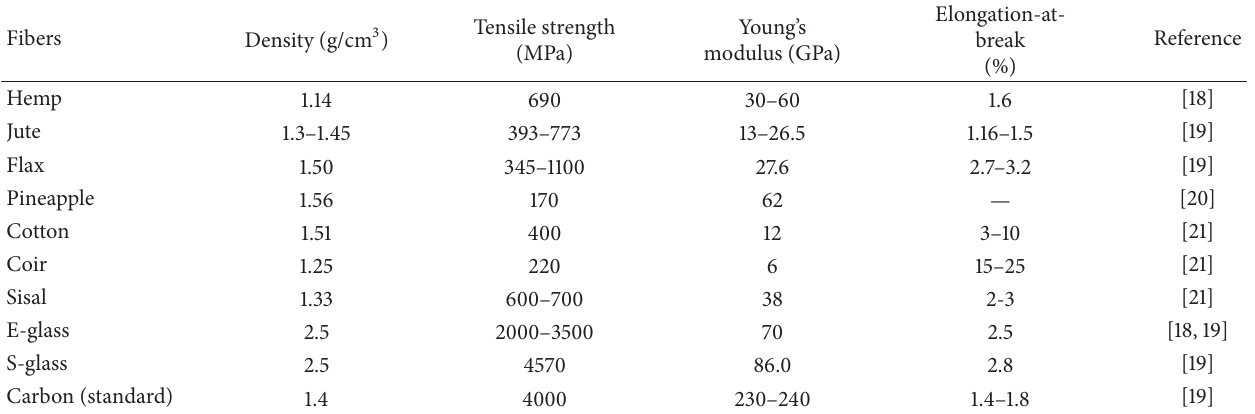
Table 2: Mechanical properties of some natural fibers when compared with conventional